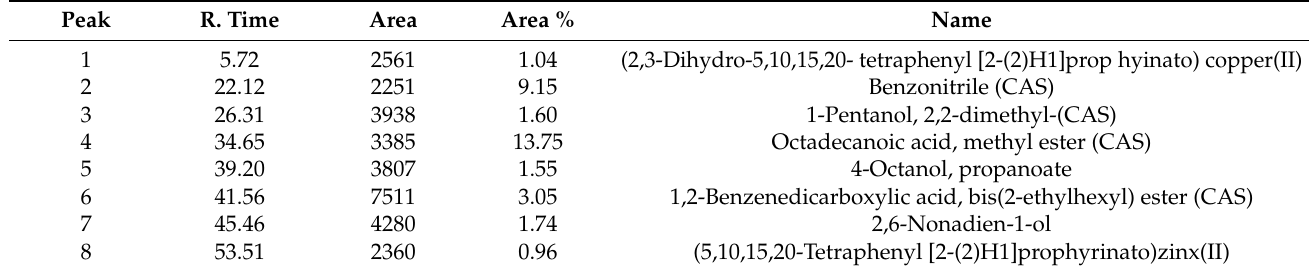
Figure 1. Callus adequate mass ( A ); GC–MS chromatograms of callus elicited by control ( B ); citric acid ( C ); L–ascorbic acid ( D ). Table 2. GC–MS analysis of R. damascena callus in the control